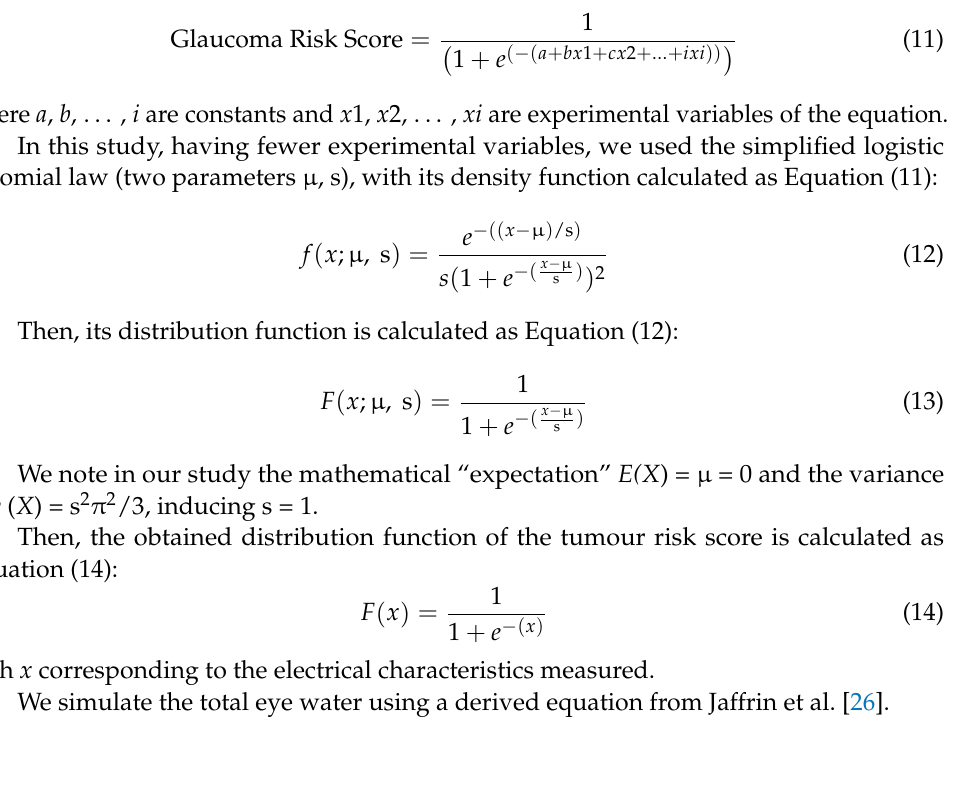
Figure 7. Evoluted 3D rendering Impedance Eye Recording (IER).